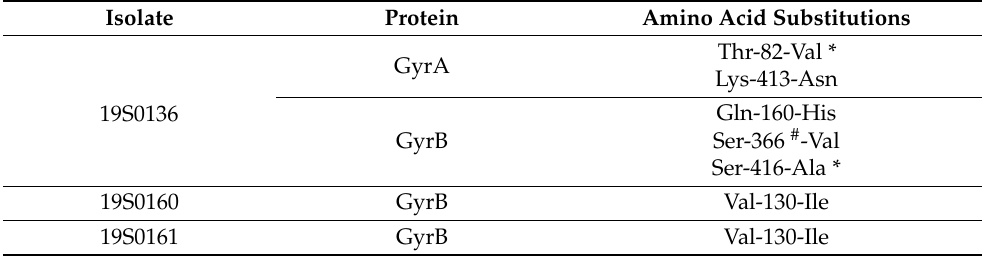
Table 4. Amino acid substitutions in gyrase proteins in C. difficile isolates from SAC. Isolate